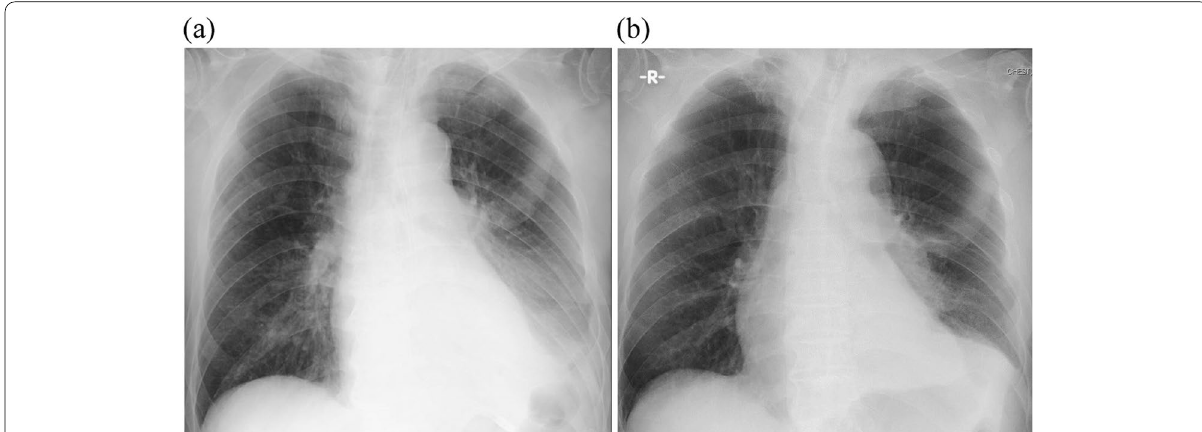
Fig. 3 Chest radiograph showing reappearance of atelectasis in the left lower lung field on day 19, after extubation ( a ), and on day 30, after resolution following resumption of intrapulmonary percussive ventilation ( b )